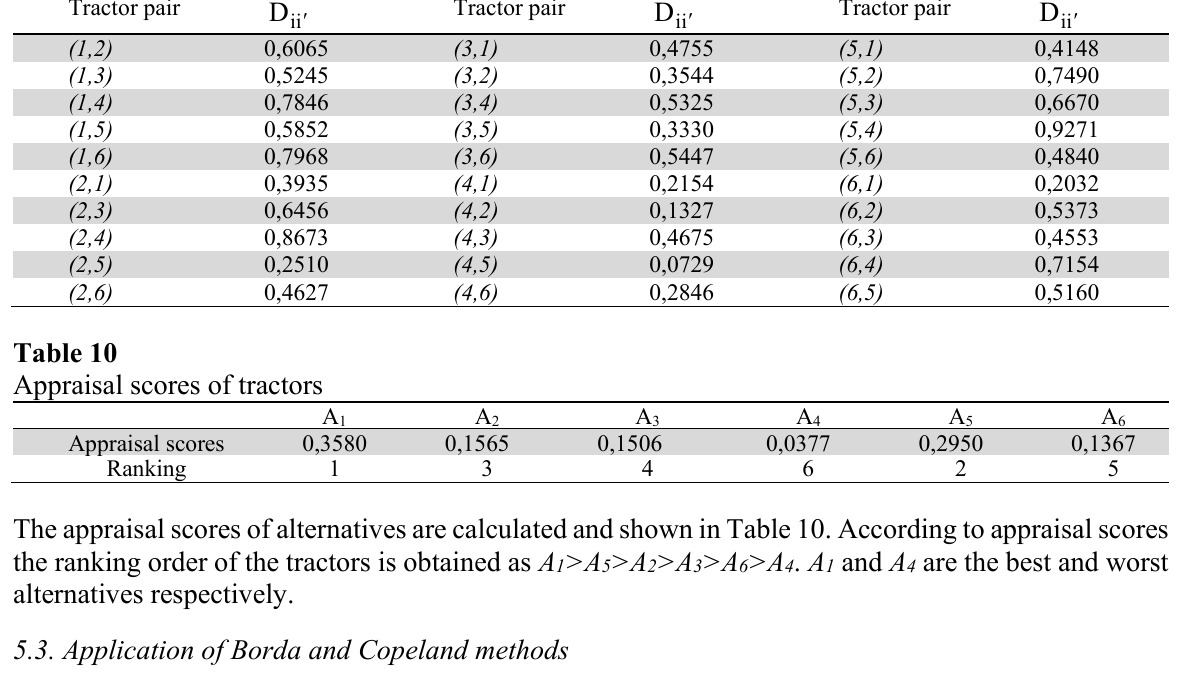
Overall dominance scores Tractor pair